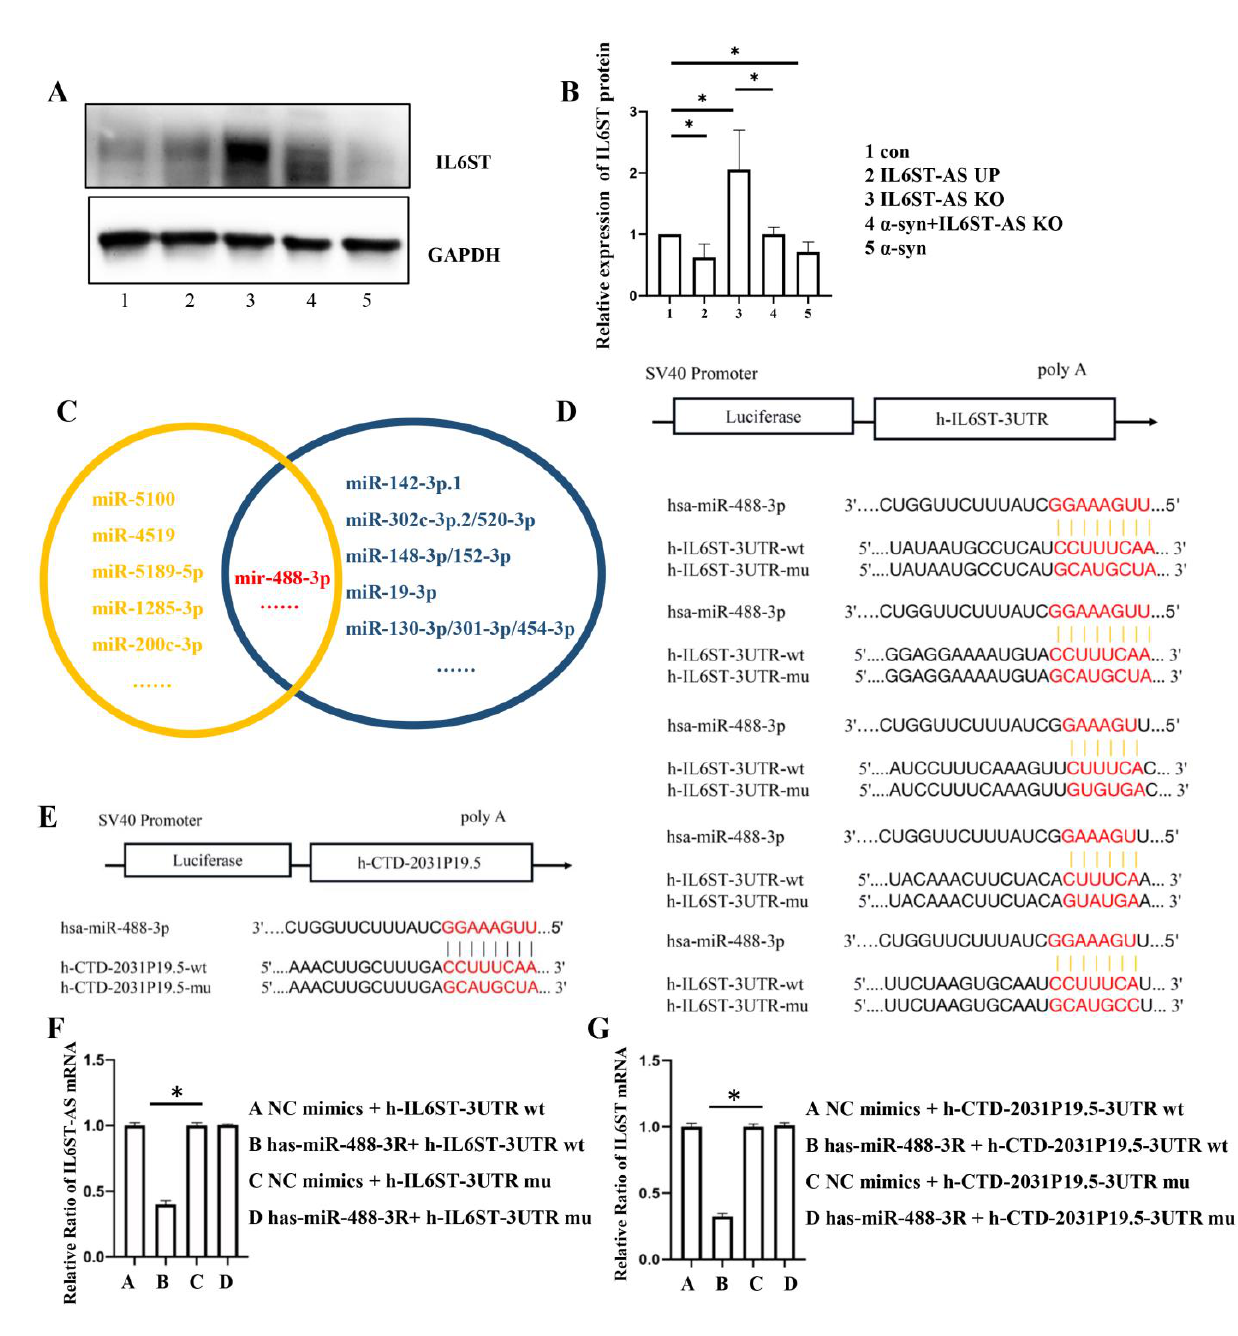
Figure 2. α -synuclein decreased the expression of IL6ST by regulating IL6ST-AS. HMC3 cells were divided into five groups: control (con), IL6ST-AS UP, IL6ST-AS KO, α -synuclein-induced (25 µ mol/L) HMC3 cells ( α -syn), and α -syn + IL6ST-AS KO. ( A ) The expression of IL6ST was detected by Western blot in HMC3 cells. ( B ) Quantitative data of Western blots in ( A ). Data = mean ± SD, * indicates p < 0.05. ( C ) Prediction results for IL6ST-AS lncRNA-binding miRNA and IL6ST mRNA-binding miRNA from two databases, LncBase and TargetScan. ( D ) Predicted miRNA binding sites within human IL6ST. ( E ) Predicted miRNA binding sites within IL6ST-AS (h-CTD-2031P19.5). ( F ) h-IL6ST-3UTR and has-miR-488- 3R mimics’ co -transfection obviously restrained luciferase activity by dual-luciferase reporter assay. ( G ) h-CTD-2031P19.5-3UTR and has-miR-488- 3R mimics’ co -transfection obviously restrained luciferase activity by dual-luciferase reporter assay.